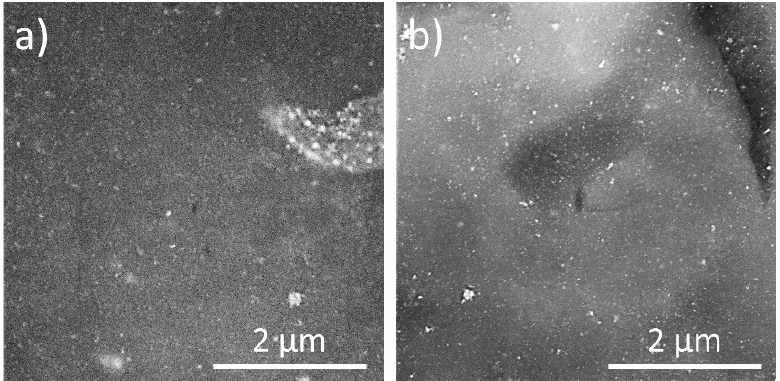
Figure 5. SEM images of the surfaces of chitosan / Ag NP composites prepared using a plasma-solution system with ( a ) liquid cathode and ( b ) liquid anode. Images were obtained in backscattered electron mode. Treatment time, 30 min.